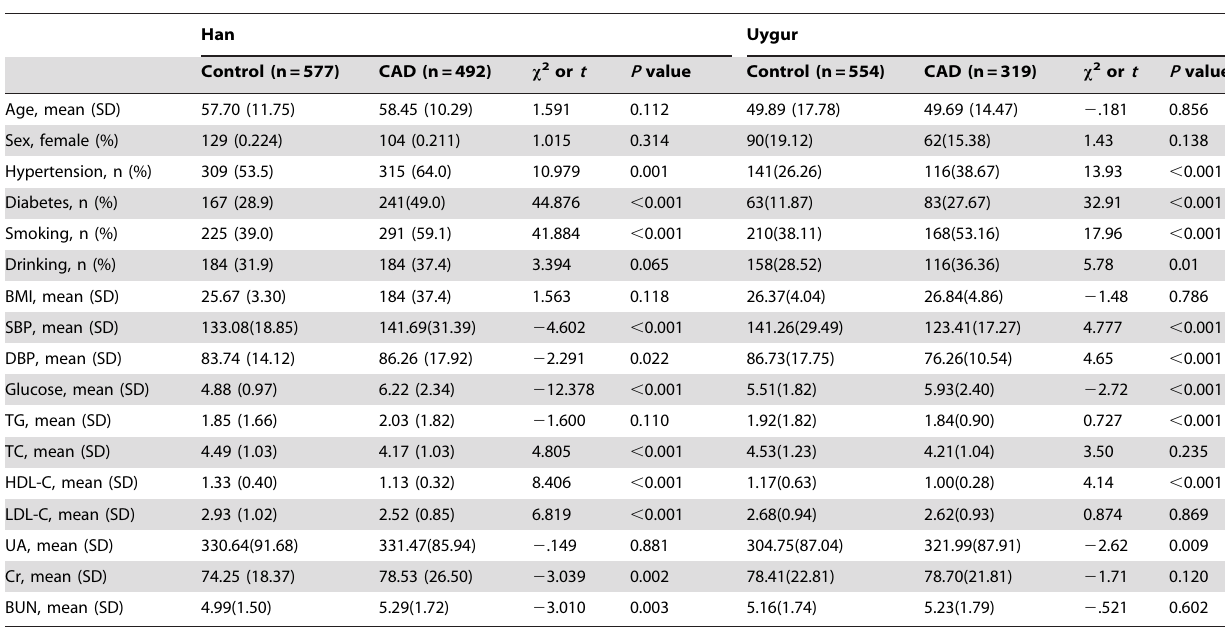
Table 1. Characteristics of the